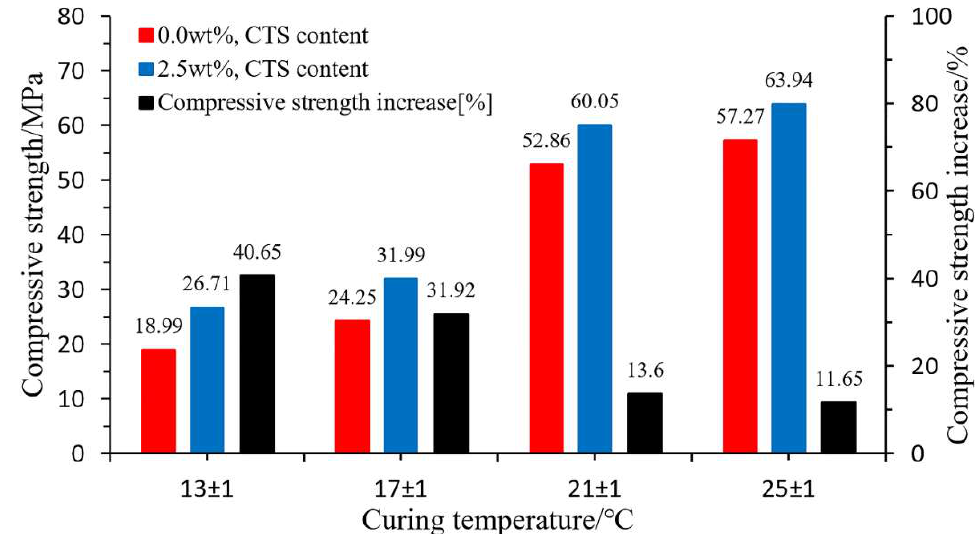
Figure 25. Compressive strength of the polyurethane (PU)/sodium silicate (WG)-0.0 wt.% and PU/WG-2.5 wt.% specimens at different curing temperatures for three days [113].